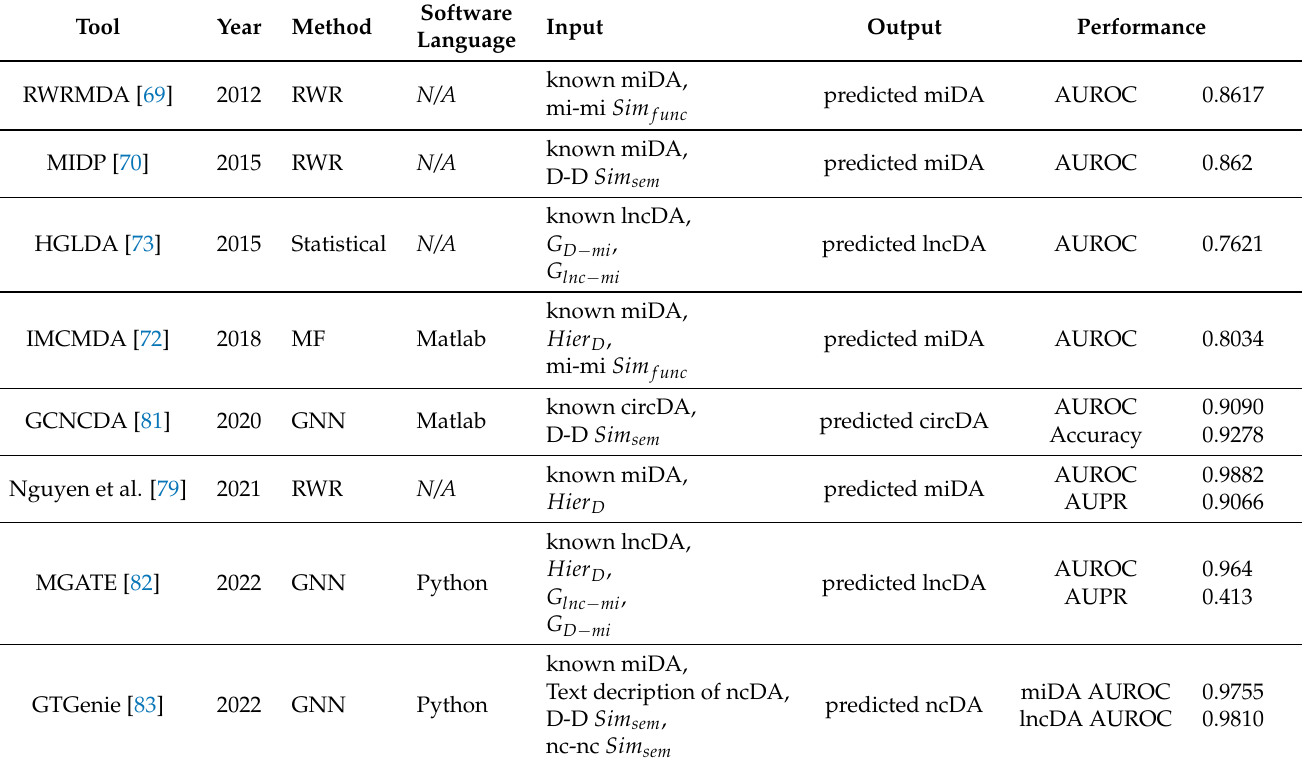
Table 3. Detailed information of representative direct ncDA predictive tools. D: Disease, DA: Disease Association, G i − j : association graph of i and j , Hier i : hierarchy of i , Sim func : functional similarity, Sim sem : semantic similarity, AUROC: Area Under Receiver Operating Characteristic curve, AUPR: Area Under Precision Recall Curve, N/A : Not